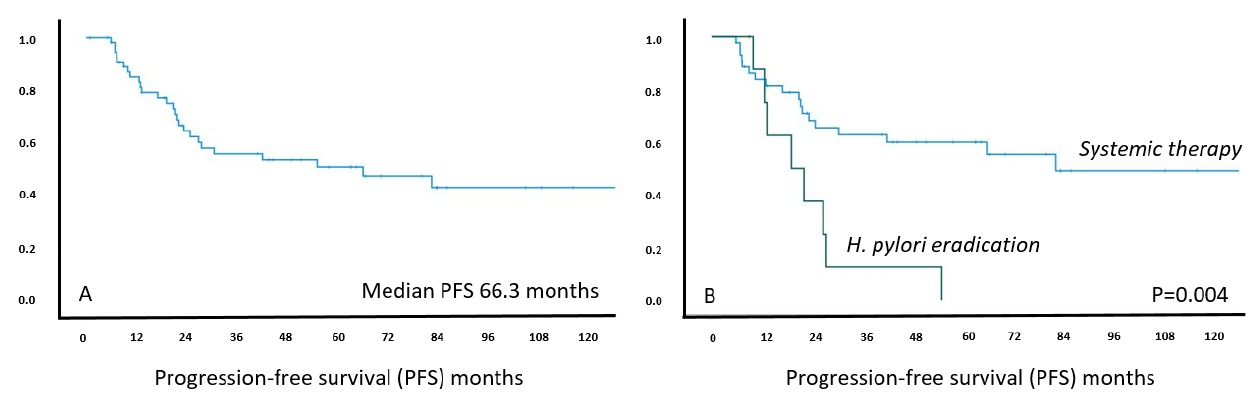
Figure 4. Kaplan–Meier curve for estimated progression-free survival in H. pylori negative MALT lymphoma patients ( n = 57) (left panel A ) and treated with systemic treatment versus H. pylori eradication (right panel B ), respectively. X-axis: follow-up in months; Y-axis: cumulative progression-free survival.